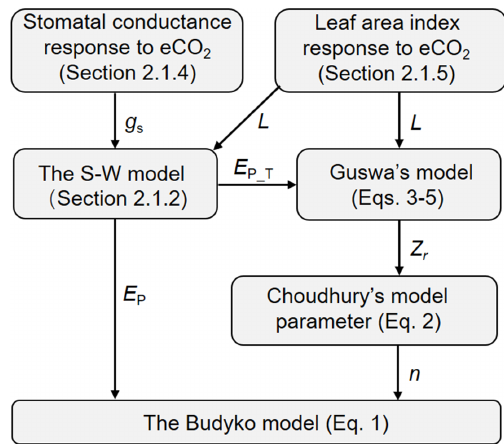
Figure 1. Flowchart of using the analytical models to detect the eCO 2 impact on Q . The terminologies used are explained in the following text (Sect. 2.1.1 through to